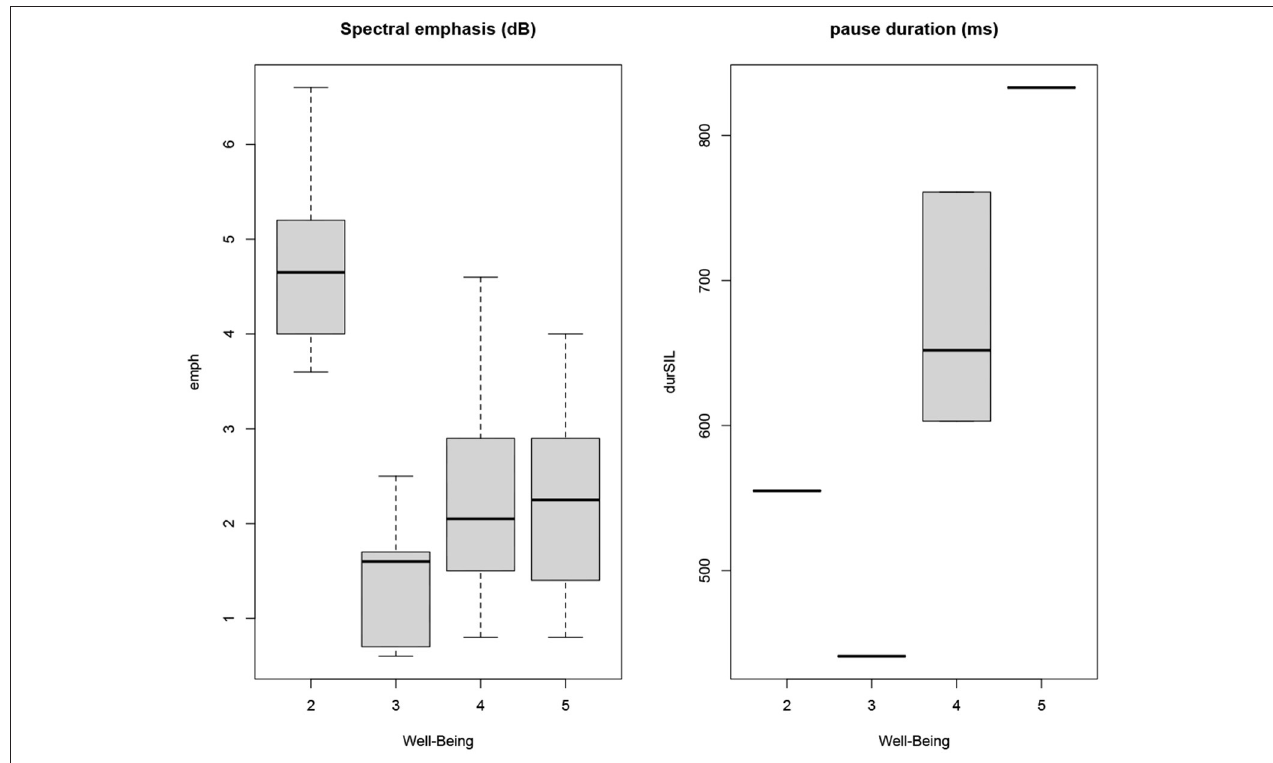
FIGURE 5 | Boxplots of the two acoustic parameters that predict wellbeing for the EP dataset. Results for male reciters